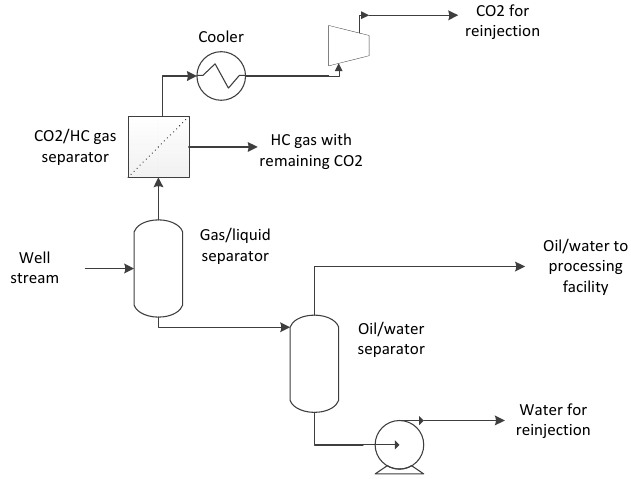
Figure 9. Main functions of a typical processing concept for CO 2 -EOR (courtesy Aker Solutions).